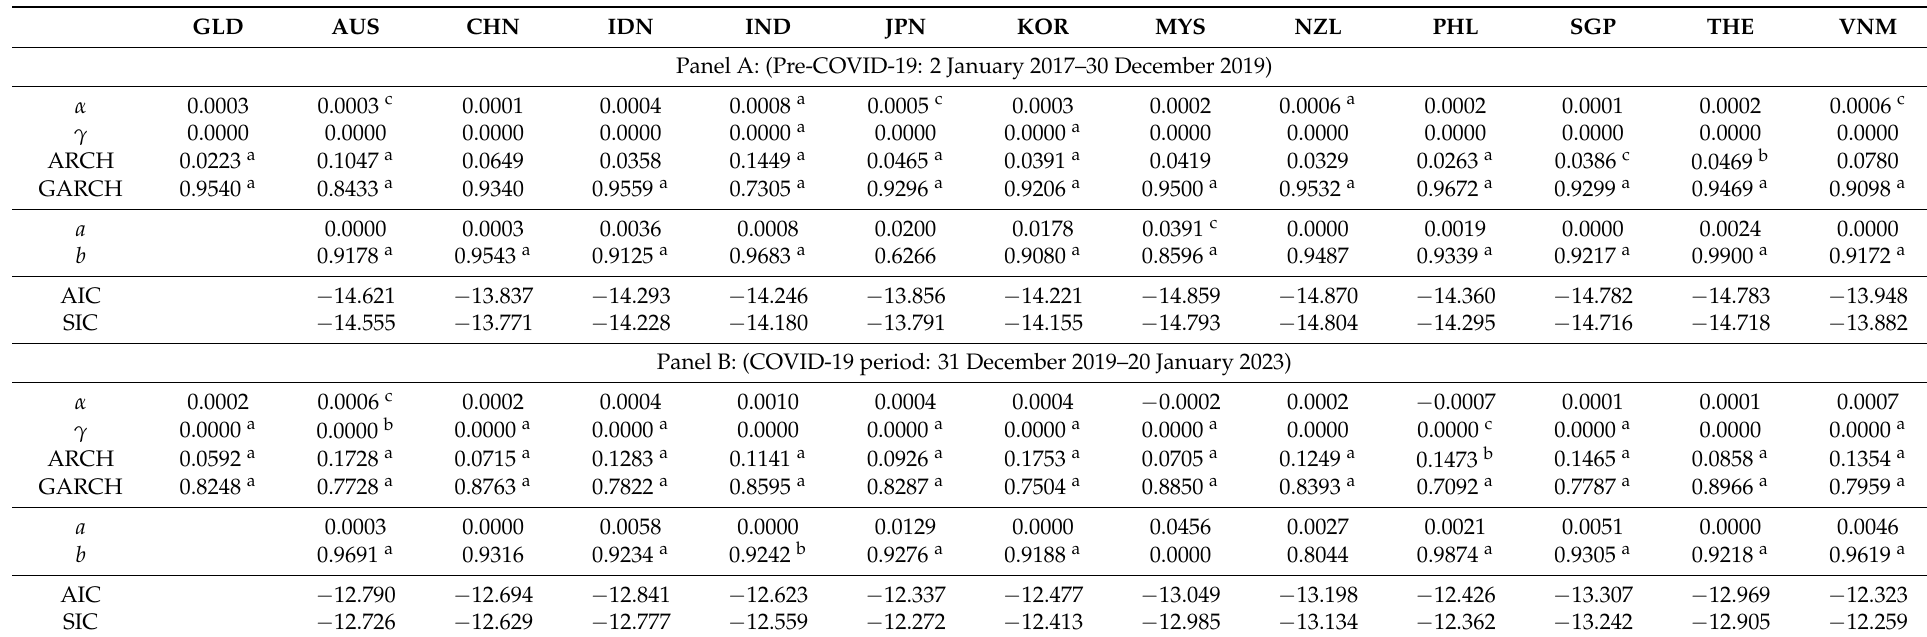
Table 3. DCC–GARCH estimated results between gold and ASEAN+6 stock